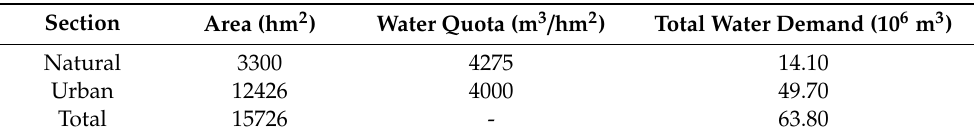
Table 4. River outside water demand of the study area.